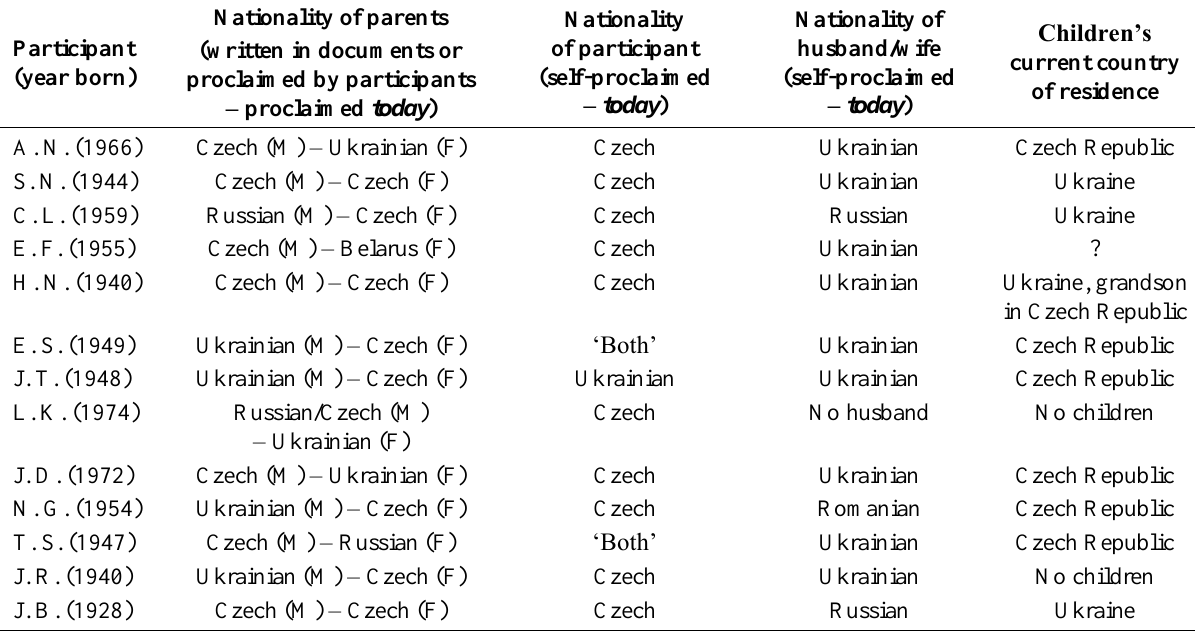
Table 2. Nationalities of participants and children’s country of settlement